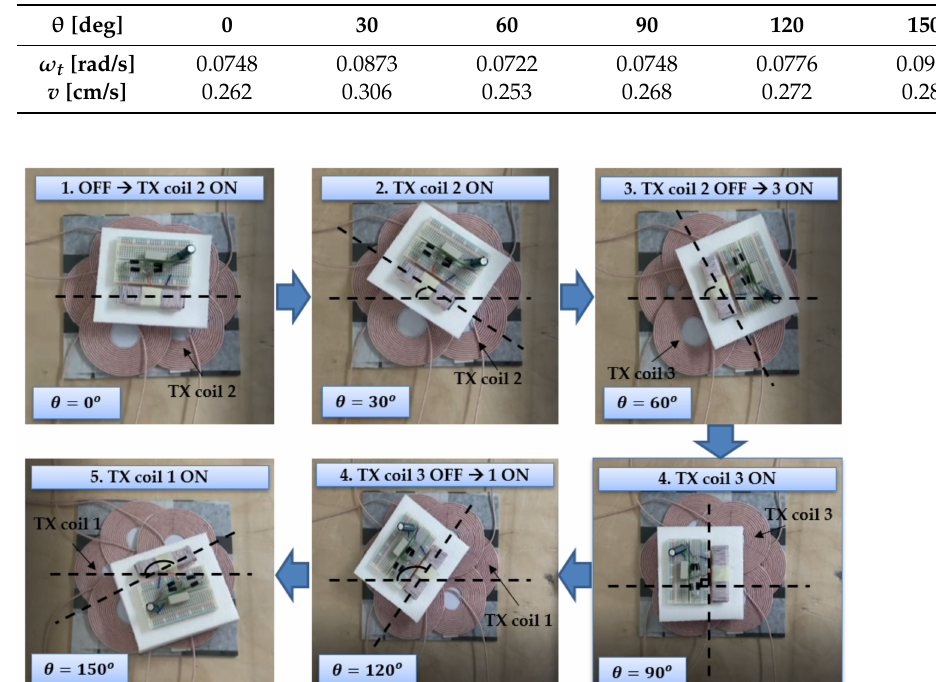
Figure 12. Torque generation process of RX coil according to turning on/off of TX coil. θ is the angle between TX coil 1 and RX coil. When the TX coil is turned on sequentially, the RX coil rotates clockwise to generate